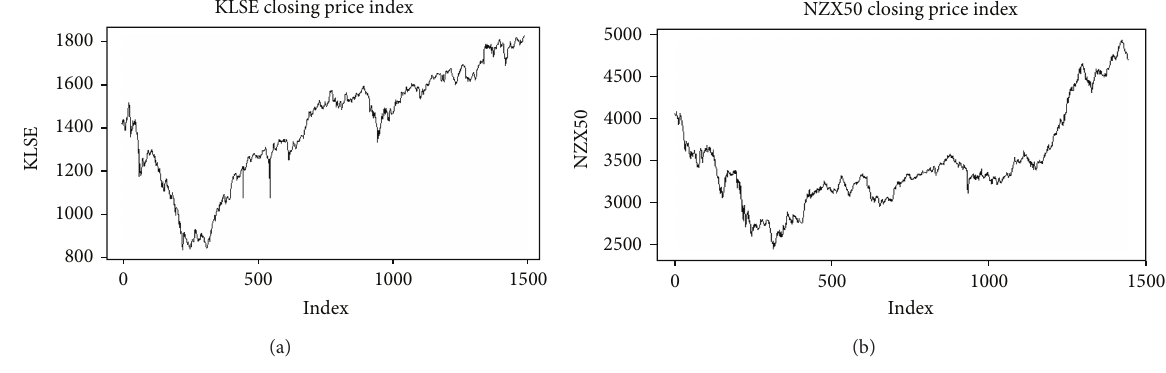
Figure 1: (a) and (b) KLSE price and NZX50 closing price index, respectively.